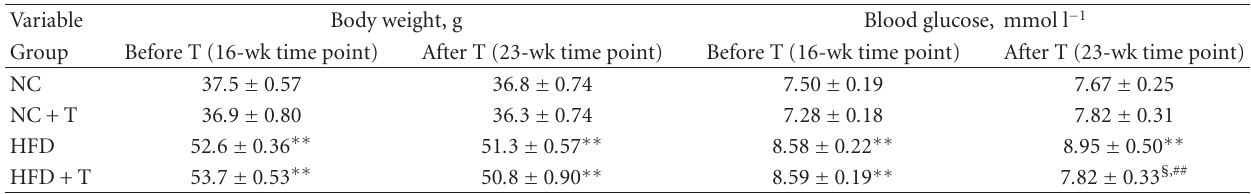
Table 1: Body weights and non-fasting blood glucose concentrations in normal chow and high fat diet-fed mice maintained with and without PMI-5011